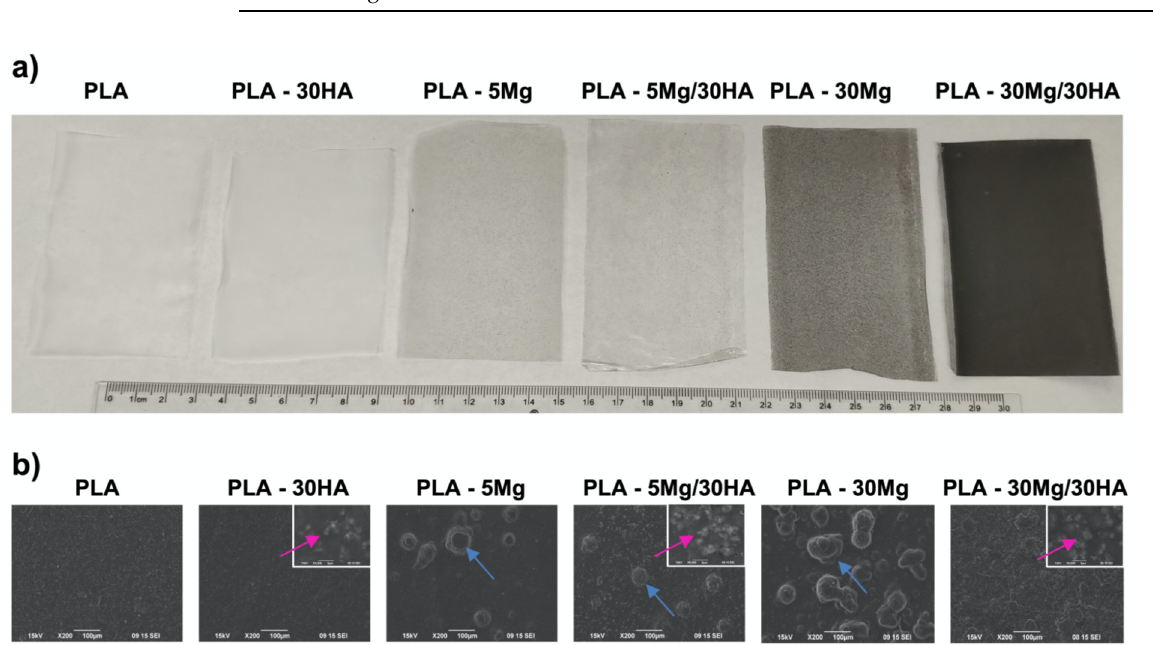
Figure 1. ( a ) Membranes macroscopic appearance and ( b ) SEM images of the different mem- branes . ( b ) Blue arrows indicate location of the Mg particles observed as structures of 50 to 120 µm, while pink arrows highlight HA particles of 1 to 3 µm.